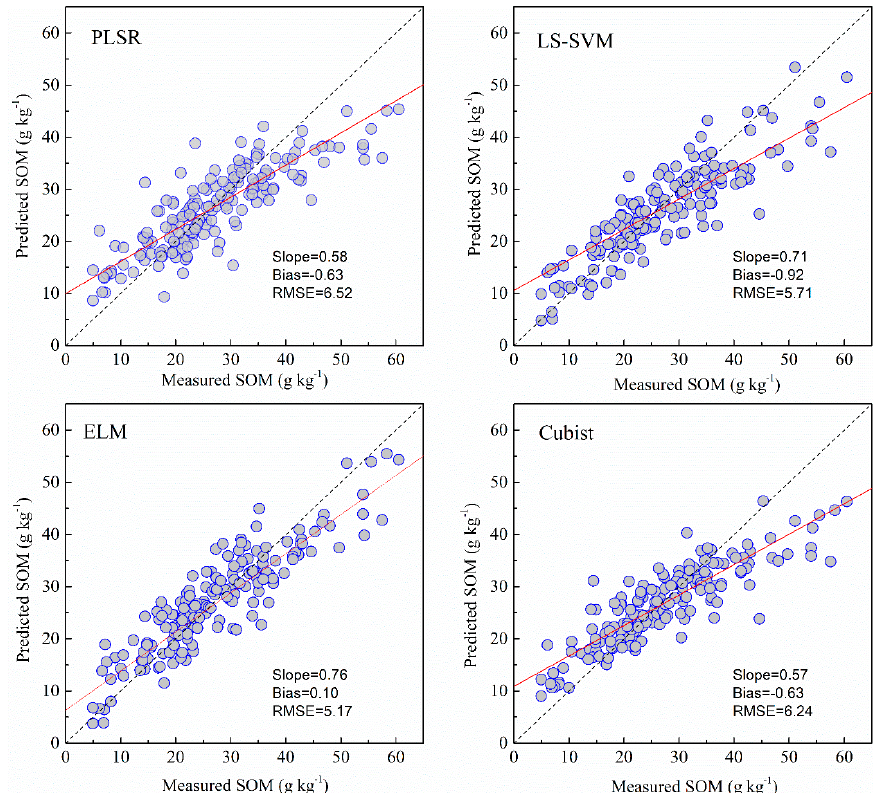
Figure 6. Predicted values against measured values of the validation set for SOM using the PLSR, LS-SVM, ELM and Cubist methods with bands reduced by GA.